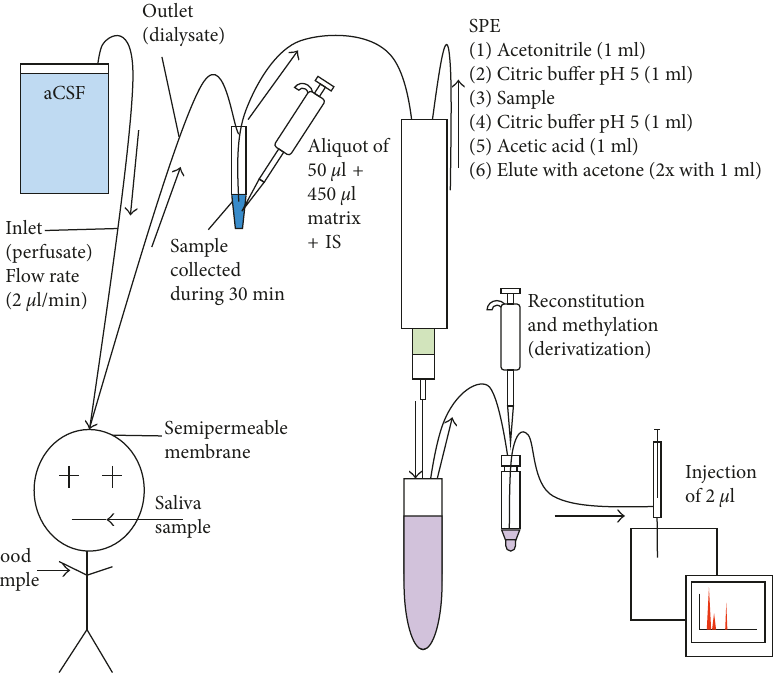
Figure 4: Sample preparation for the GC-MS analyses